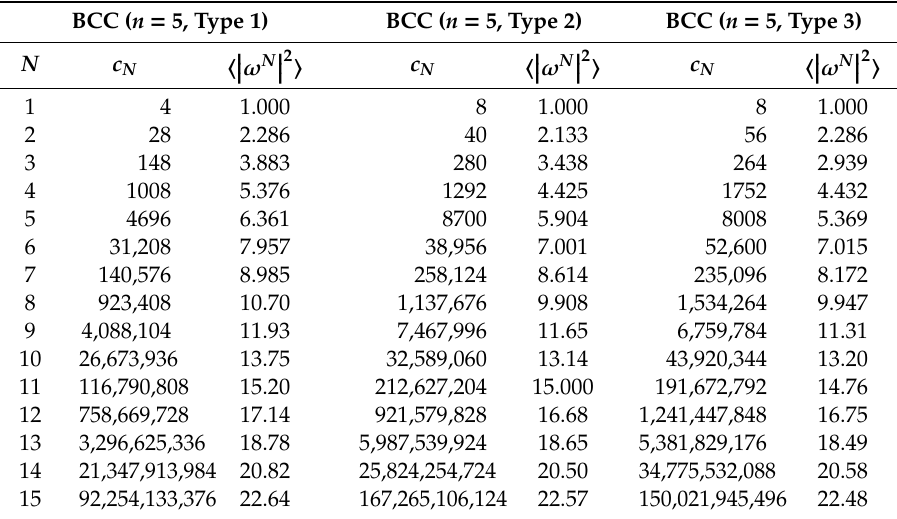
Table A9. Properties of SAWs on the BCC lattice with five layers between the confining plates ( n = 5, Type 1, 2, 3).